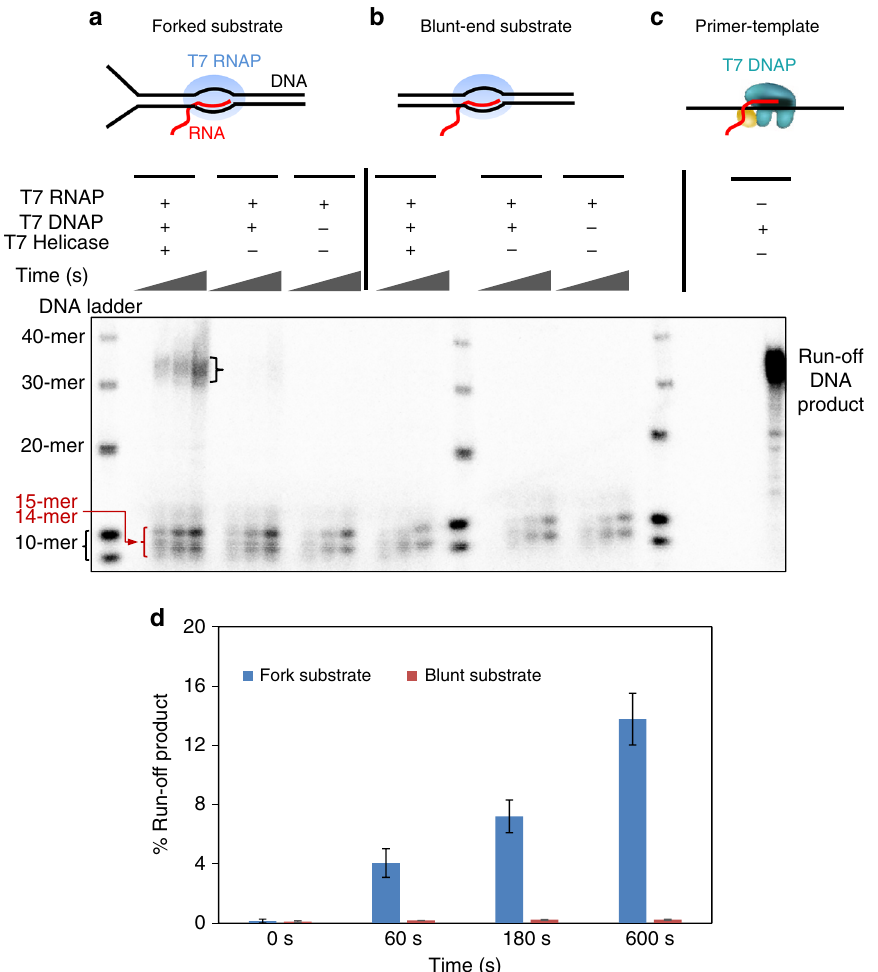
Fig. 4 Bulk experiments on helicase and non-replicating DNAP collision with a TEC. a , b Experiments on fork DNA substrate (left) and blunt DNA substrate (right) respectively. The parental DNA contained a stalled T7 RNAP and experiments were carried out with dNTP mixture spiked with [ α - 32 P]-dGTP. For each experiment, reactions were quenched at four time points (0, 60, 180, and 600 s). Samples were mixed with formamide and bromophenol blue dye and heated at 95 °C for 5 min before loading on 12% acrylamide/6M urea sequencing gels. Sequencing gels show the kinetics of the RNA primer extension on either the fork substrate or the blunt substrate. The run-off DNA product is 38-nt long. The products running close to the 10-nt DNA markers are 14- mer and 15-mer resulting from dNTPs addition by T7 RNAP to the 12-mer RNA primer. c Replication reaction performed with just the primer annealed to the template. Experiment was carried out with dNTP mixture spiked with [ α - 32 P]-dGTP and T7 DNAP. Reaction was quenched at 600 s. The replication product was used as a control for quantitating the % run-off DNA products obtained in a and b . d Percentage run-off product estimated from a and